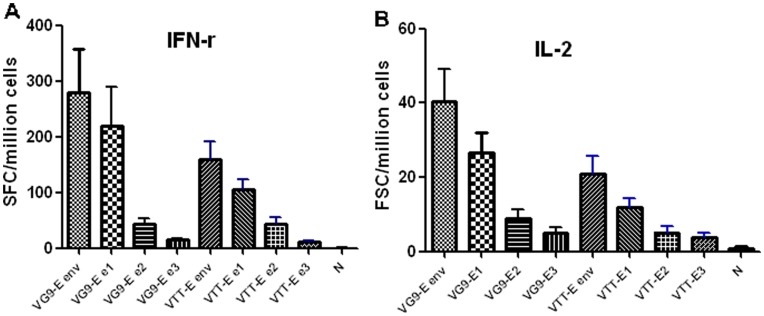
Env-specific splenic T lymphocytes secreted IFN-γ (A) and IL-2 (B) induced by VG9-E and VTT-E using ELISpot assay.The splenocytes were harvested and treated, then were added to 96 wells (in duplicate) at a seeding concentration of 4×105 cells/well. HIV-1 PTE (Env) peptides were combined with three peptide libraries (e1, e2, e3) and added to the cells at a final concentration of 5 µg/mL for each peptide library. Data for all SFCs was subtracted from the background (mean SFCs without PTE stimulation). SFCs for each mouse were determined as the SFCs stimulated by all 480 peptides of PTE. The data of negative control was got from mice inoculated by only a single dose of VG9-E or VTT-E.